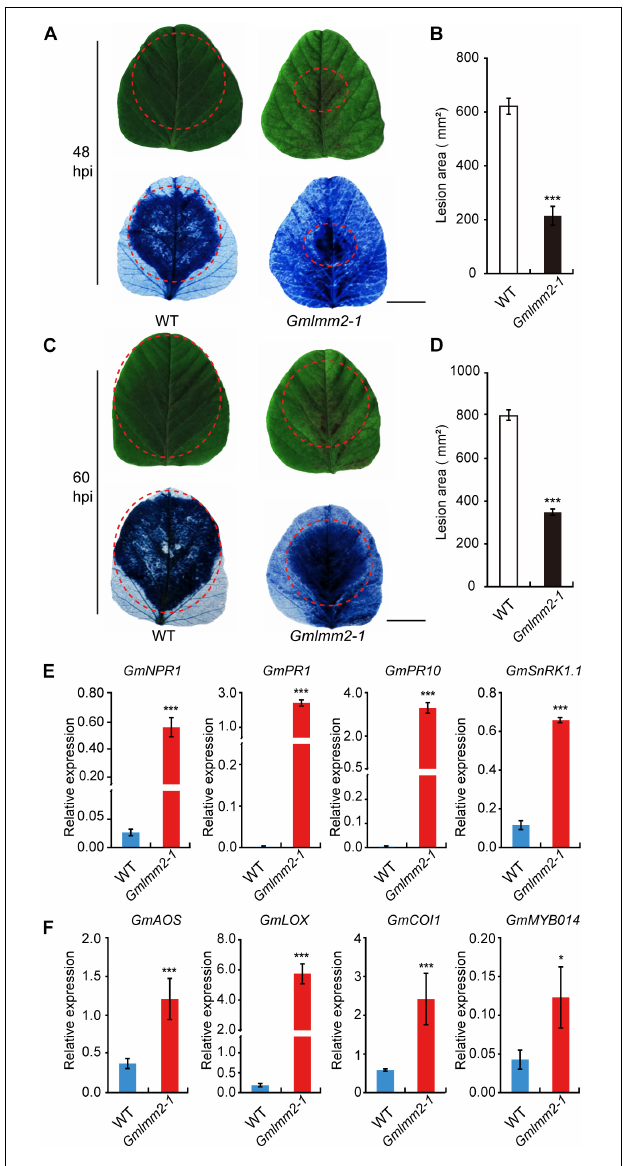
FIGURE 6 | Up-regulation of resistance-related genes and enhanced pathogen resistance. (A–D) The infection phenotypes of “Williams82” (WT) and the Gmlmm2-1 mutant at 48 and 60 hpi with Phytophthora sojae stain P7076. Trypan blue staining demonstrated that infection levels were similar to those of the leaves shown above. Scale bars = 1 cm. The sizes of the lesions were statistically analyzed corresponding to (A–C) . (E,F) The expression levels of SA-signaling and JA-signaling genes in “Williams82” (WT) and the Gmlmm2-1 mutant. The data shown are the mean values of three biological replicates and the error bars represent the standard deviation (SD). Data are presented as fold difference from the WT control after normalizing to the control gene GmActin11 . Relative expression levels are presented as means ± SD. Data are from three biological replicates. * P < 0.05, ** P < 0.01, *** P < 0.001 ( t